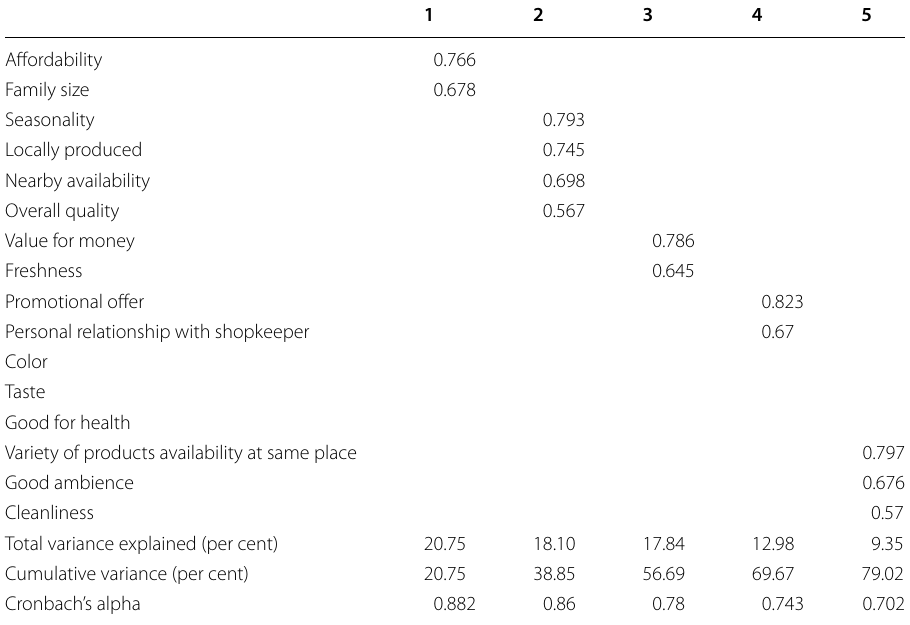
Table 9 Post-demonetization factor loading for various purchasing decision criteria for fruits and vegetables—Anand